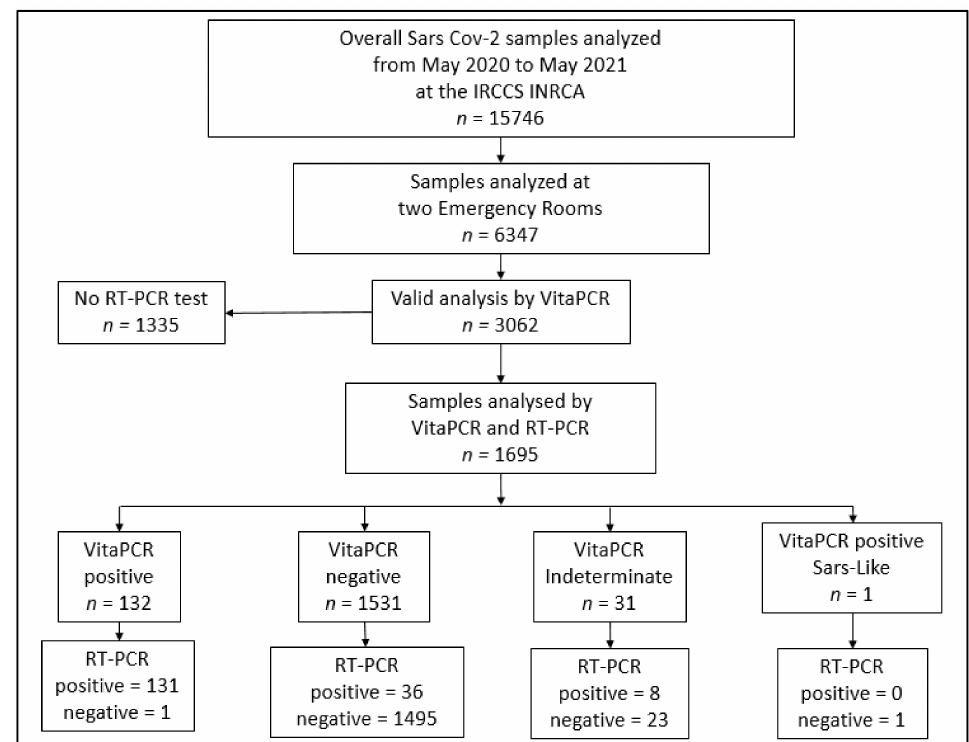
Figure 1. Flow chart of patients’ selection. Flowchart of the selection of samples analyzed for SARS-CoV-2 with both VitaPCR™ and RT-PCR methods. Abbreviations: RT-PCR, reverse transcrip- tion polymerase chain reaction; ED, Emergency